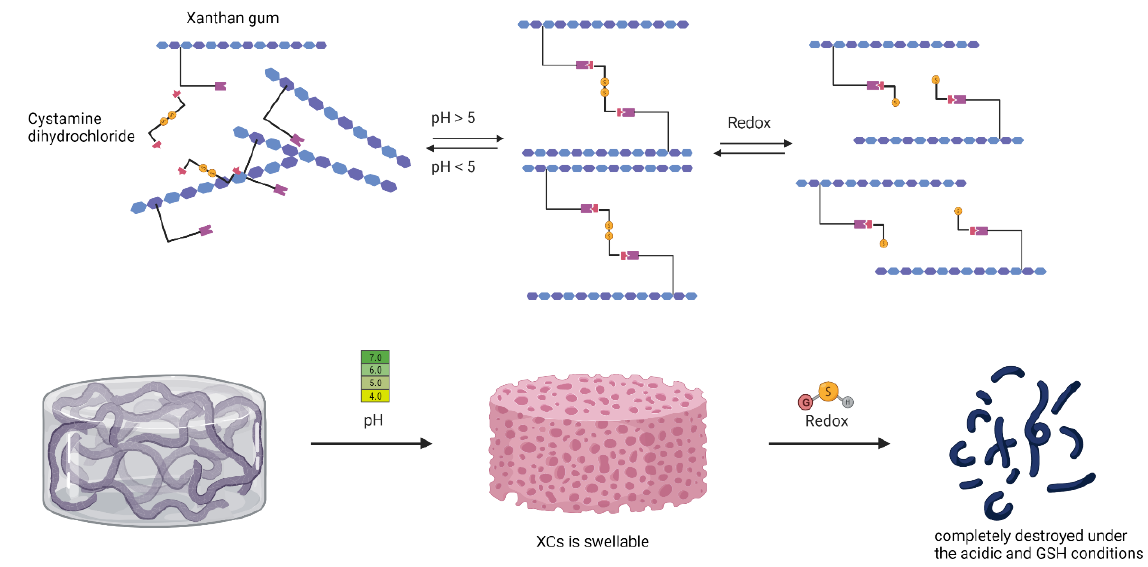
Figure 3. The mechanism of pH/redox-responsive delivery.